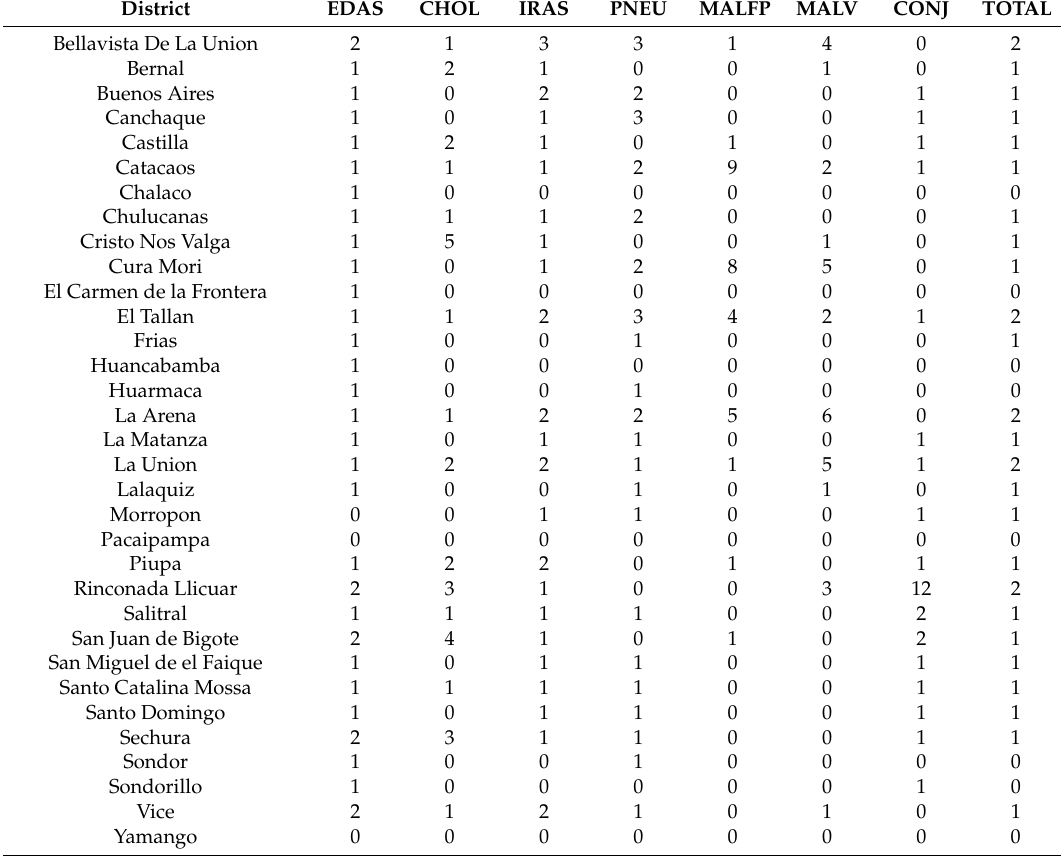
Table 3. Disease incidence burden ratio (compared to the average) by